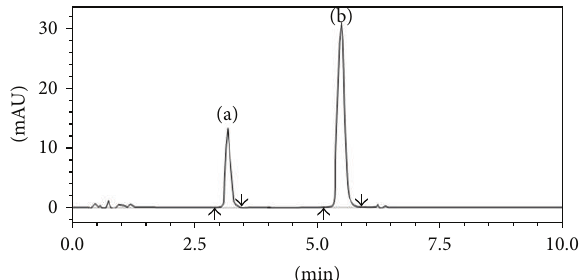
Figure 3: Chromatogram obtained from ATV (Rt 3.21) and TLM (Rt 5.40) at